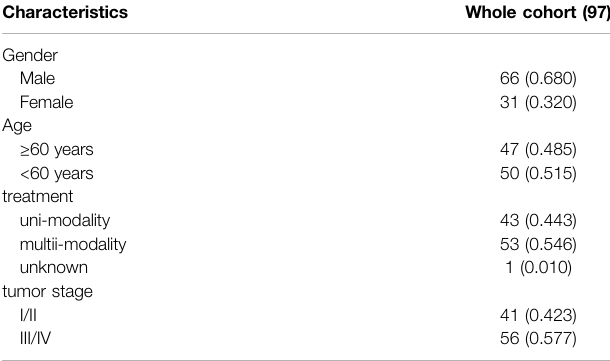
TABLE 2 | Basic information of OSCC patients in validation cohort.